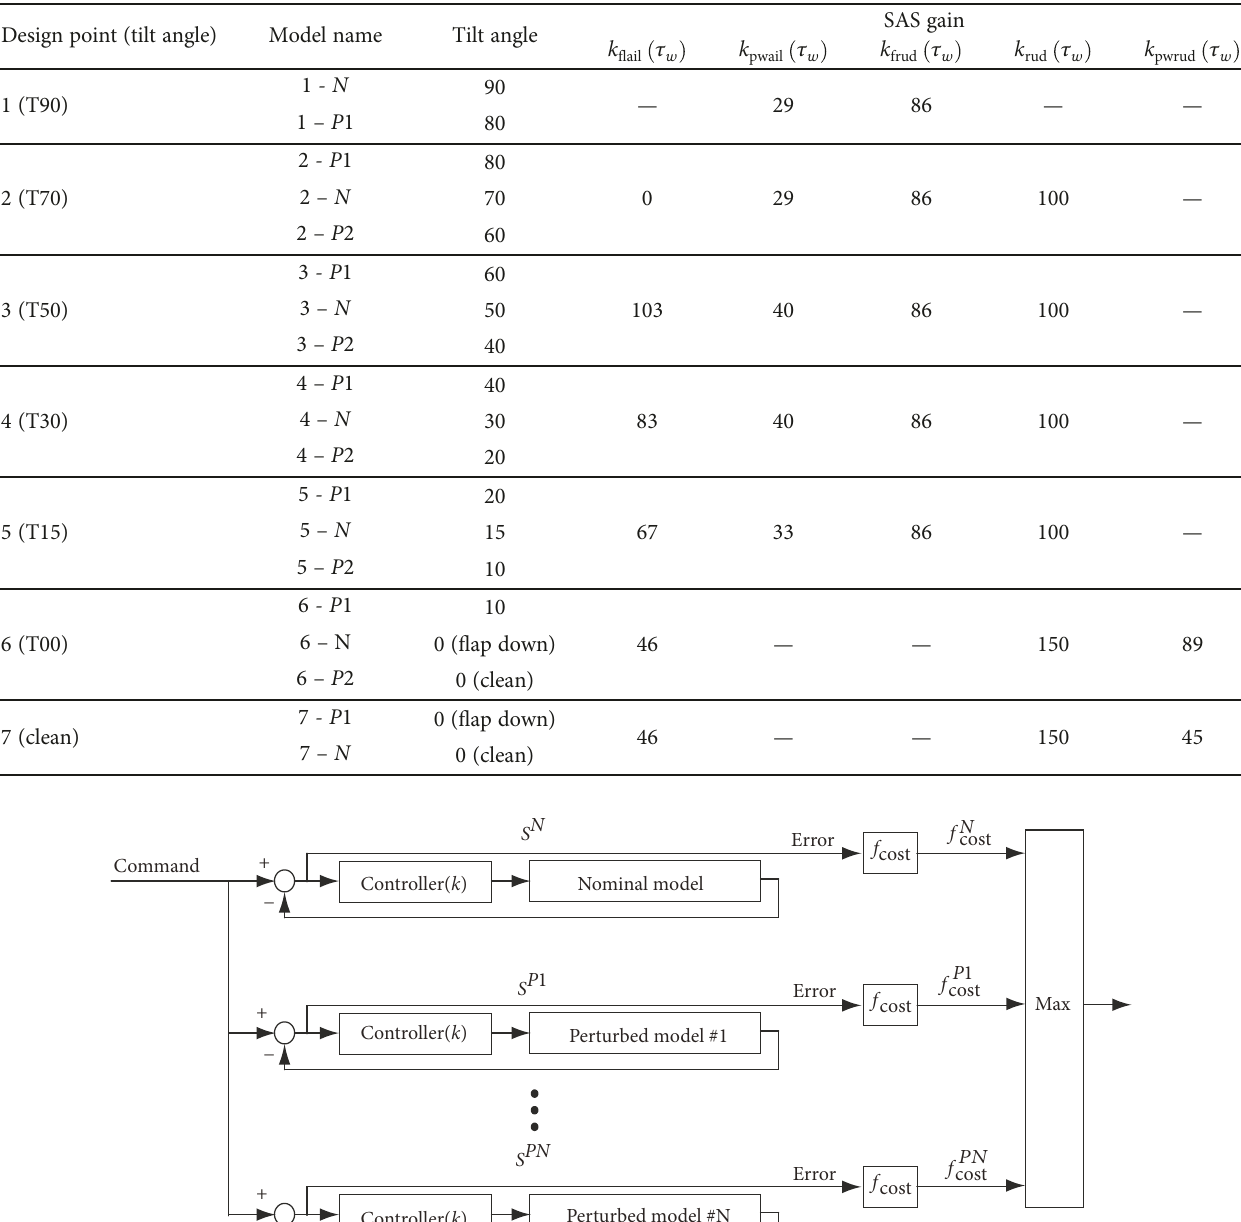
Table 1: McART3 nominal models and perturbed models ( “ N ” denotes “ nominal ” and “ P ” denotes “ perturbed ” models) and SAS gains in lateral directional motions ( “ - ” denotes disuse).